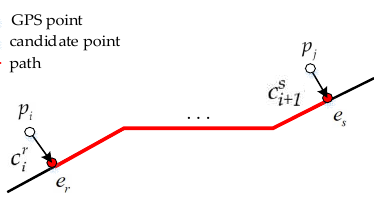
s on e ir is the on e s . c r is the s . c i+ (cid:2869) i + 1 i